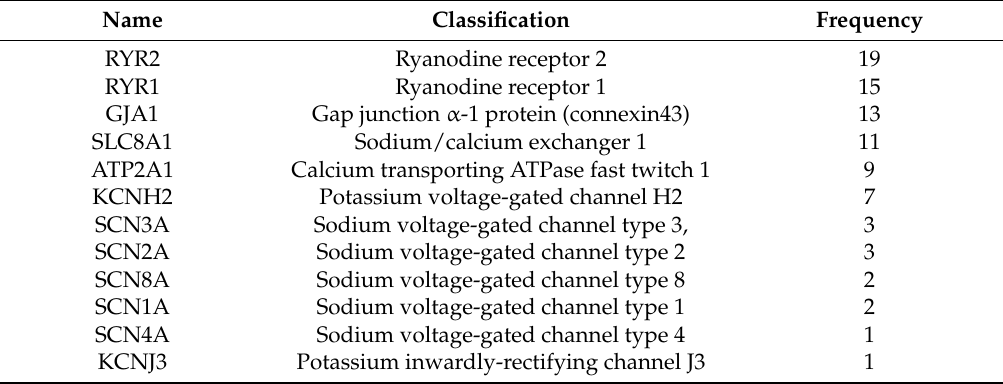
Table 2. Proteins related to aconitine alkaloids induced cardiotoxicity extracted from 274 articles.